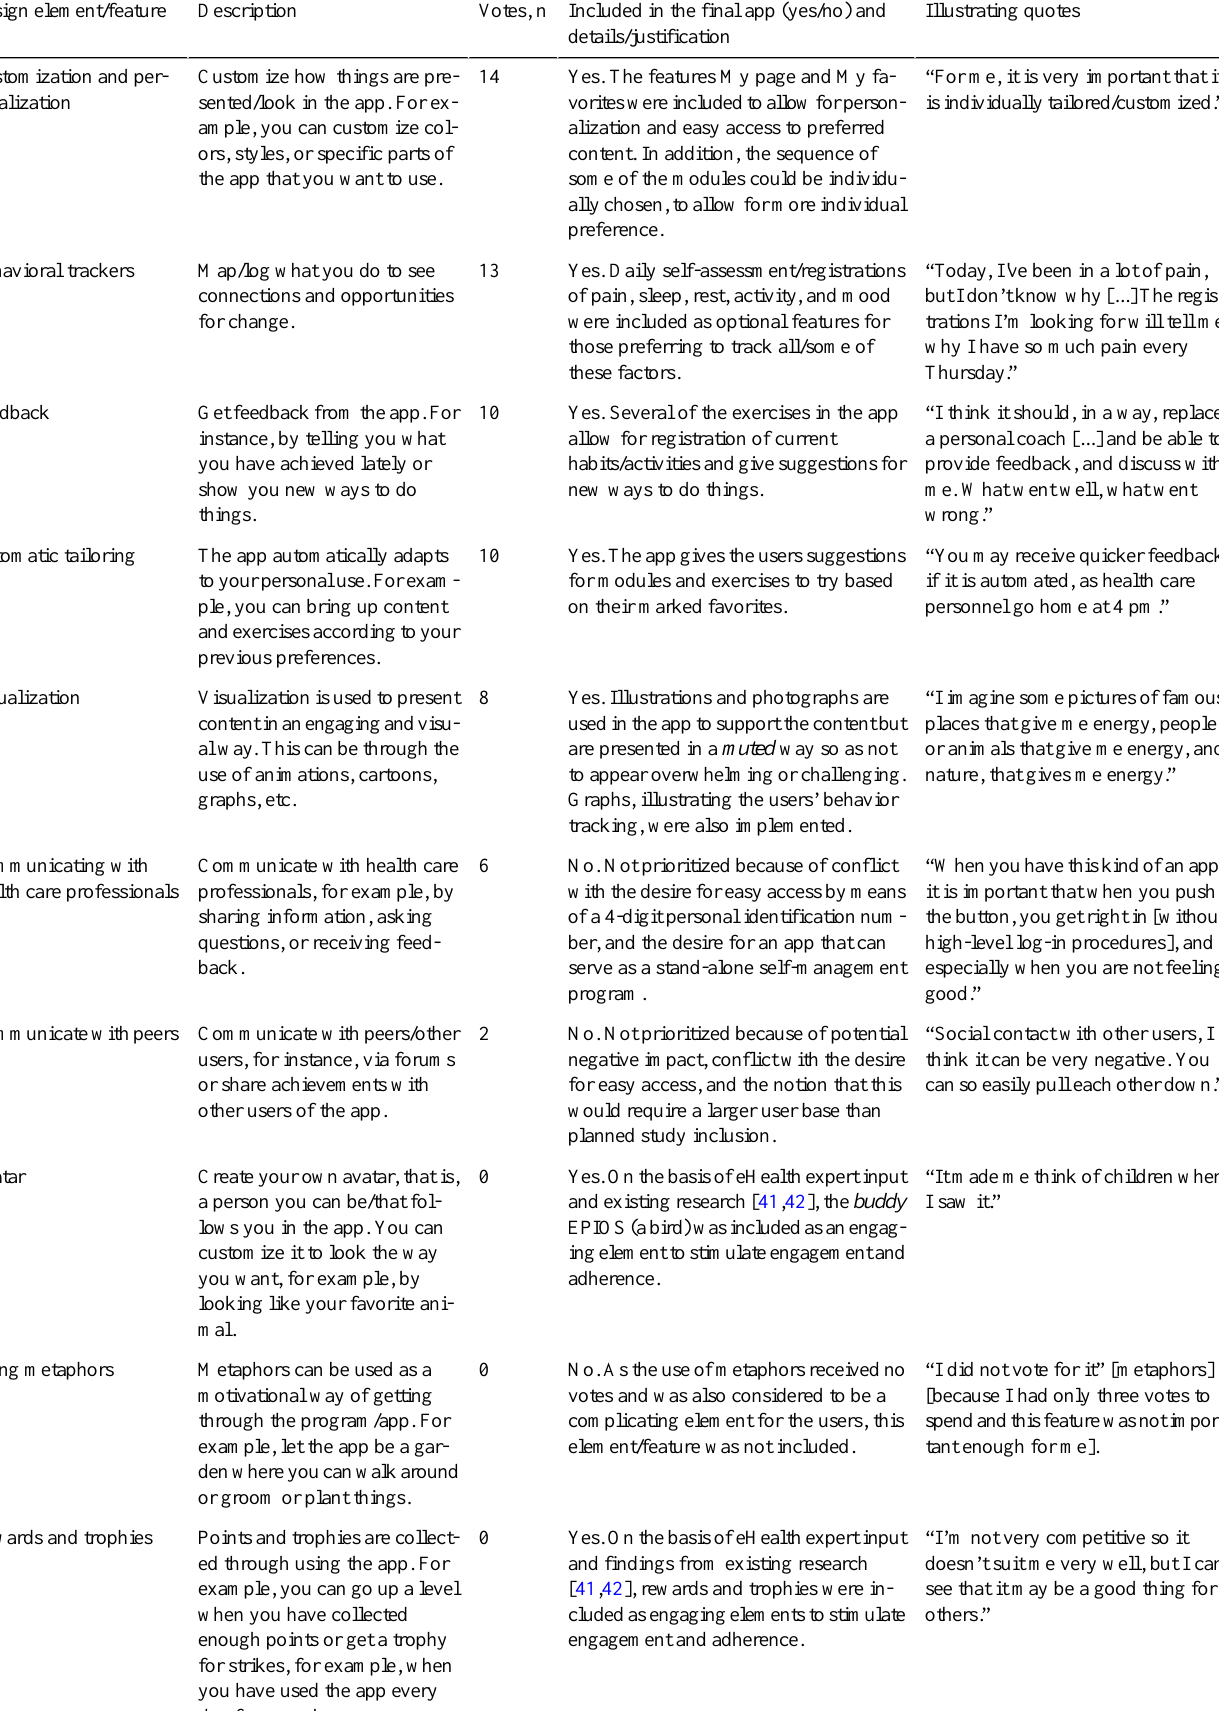
Table 5. Design elements/features: priority task voting, elements/features included, details, and illustrating